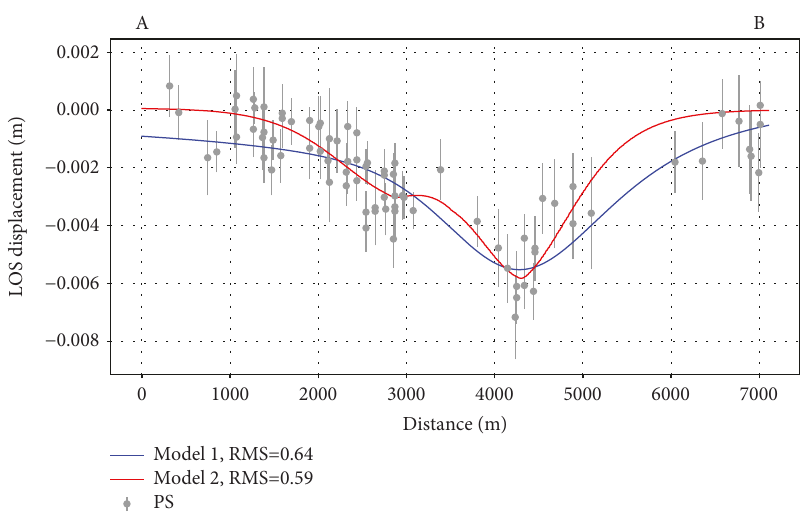
Figure 7: The best- fi tting in fl uence functions derived from the nuclei of strain solutions along the cross section. For the trace of the section, see Figure 6(a). Model 1: in fl ation point sources. Model 2: vertical tensile point sources. The PS observations and their standard deviations marked by error bars are plotted in both fi gures. Note that the LOS displacements are reported for the period of one